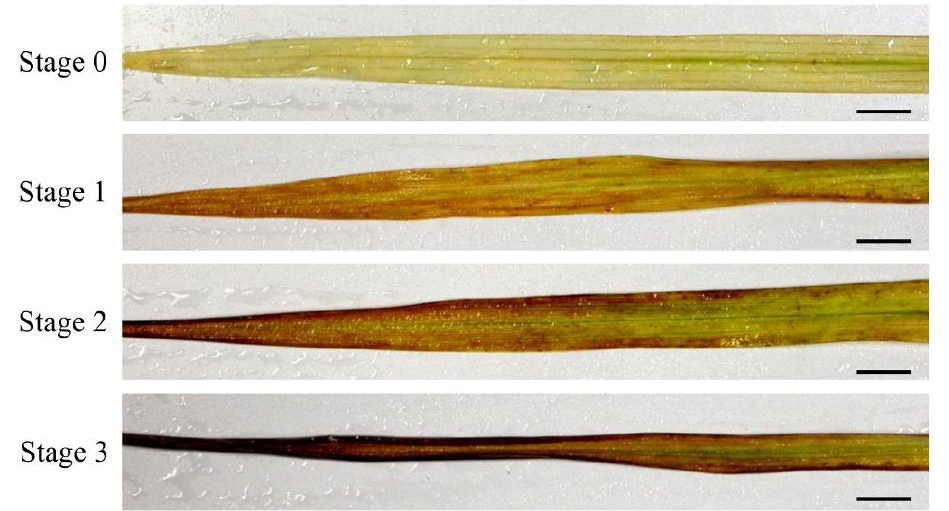
Figure 6. Presence of reactive oxygen species in hybrid leaves. 3,3-diaminobenzidine (DAB) staining was used to detect H 2 O 2 . Scale bars indicate 1 cm.